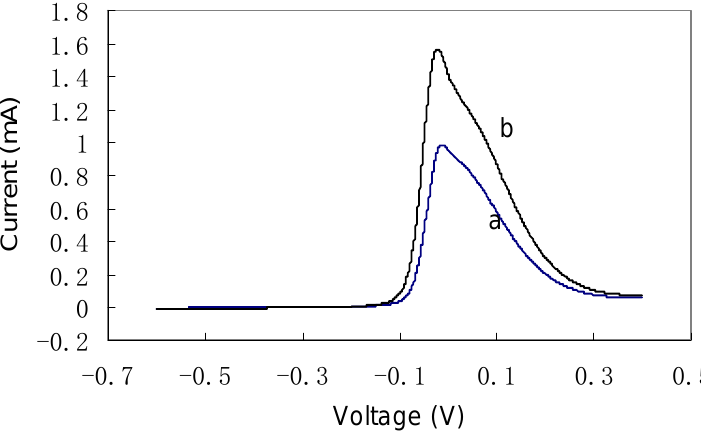
Figure 1. Typical anodic wave of cyclic voltammogram of two Chinese yellow wine samples ( k1, k3 ) in alkaline solution obtained at a copper working